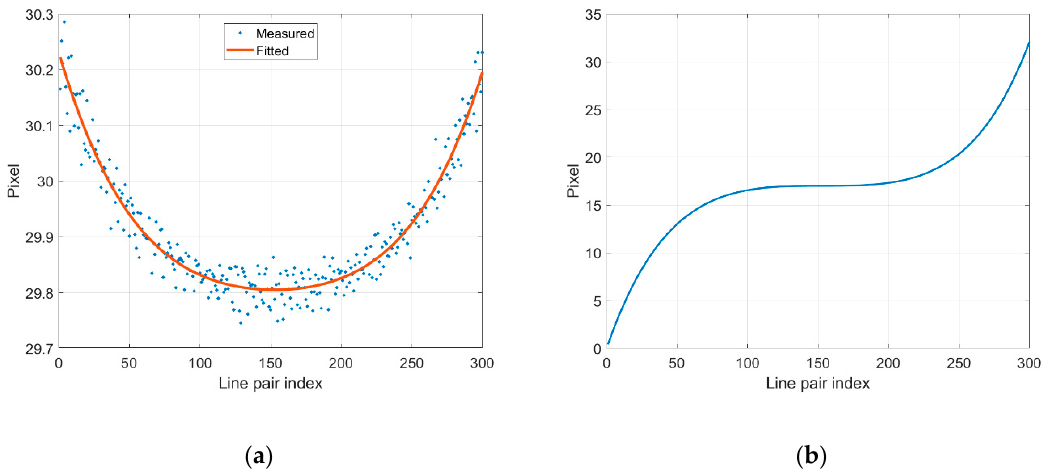
Figure 10. ( a ) Pixel numbers between a line pair; ( b ) Cumulated pixel error between line pairs.